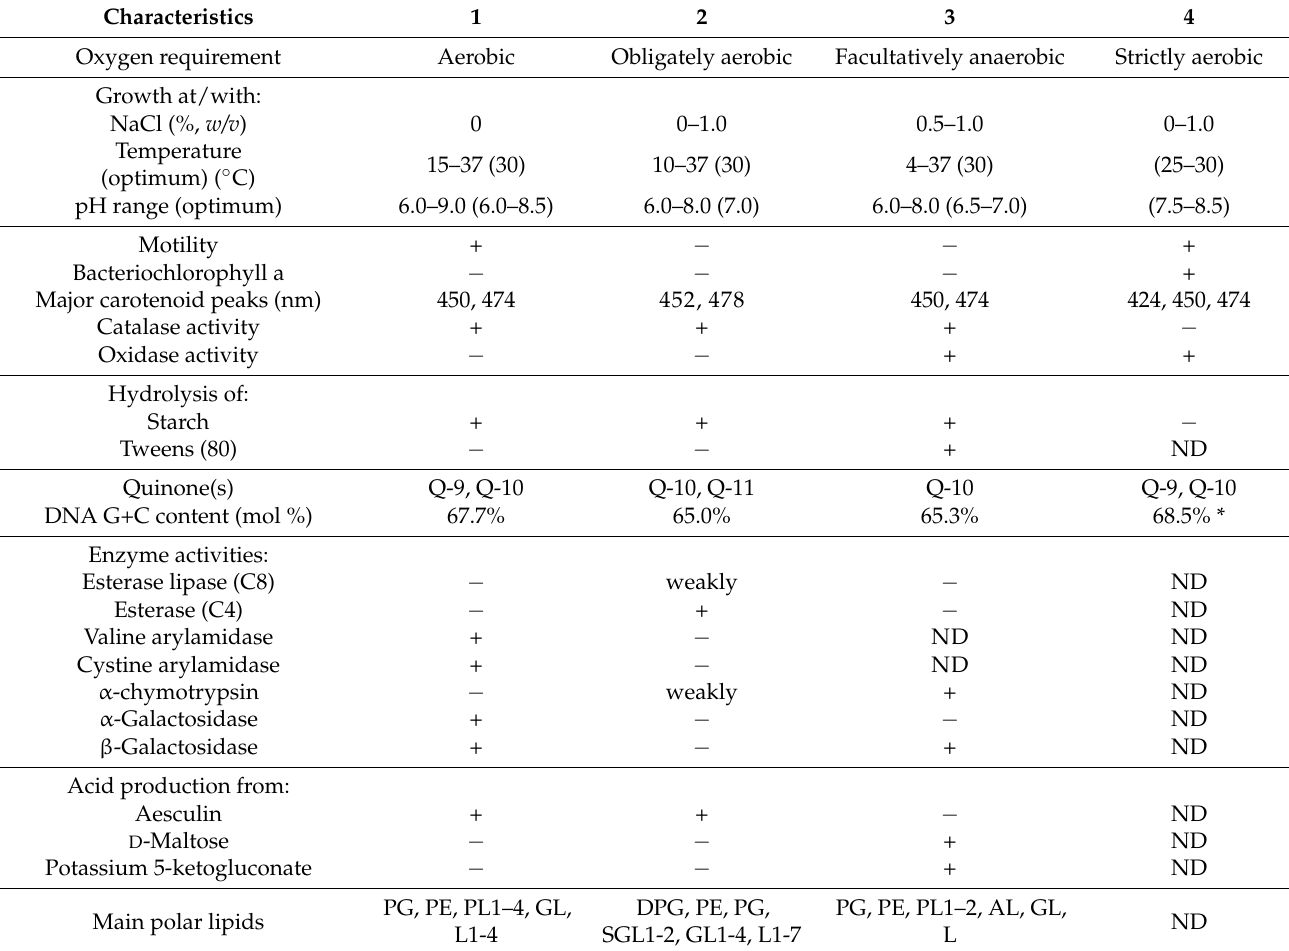
Table 2. Phenotypic characteristics distinguishing strains M6 T from other species of the genus Sandaracinobacteroides and